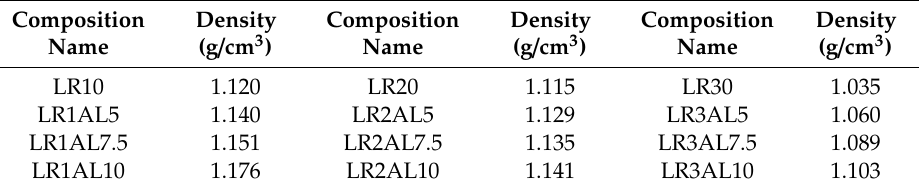
Table 2. Density of the manufactured composites.